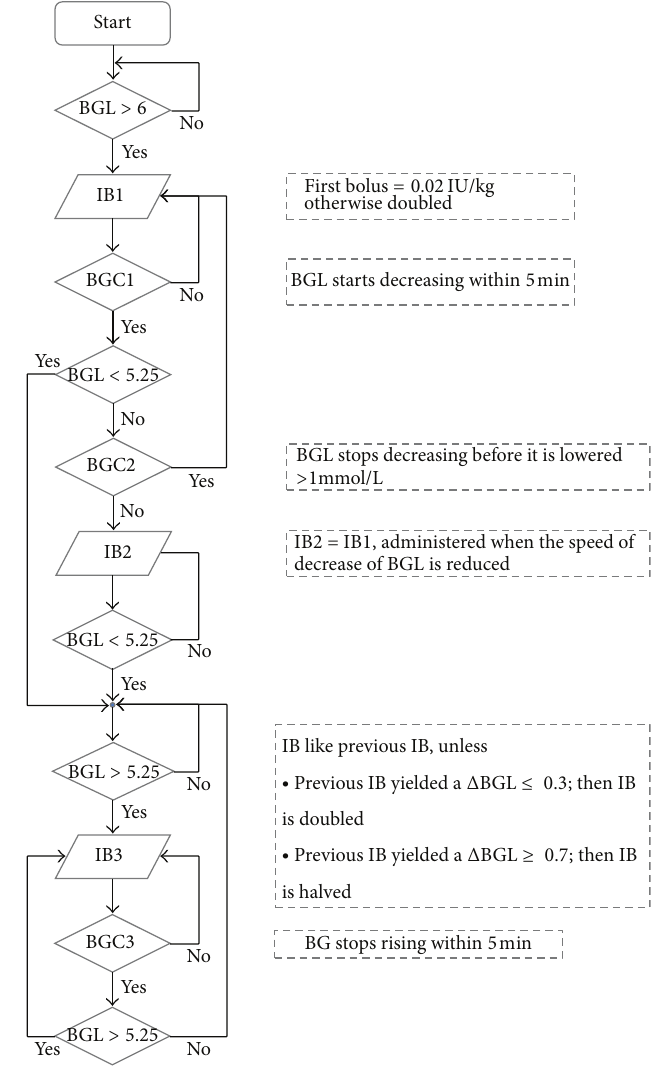
Figure 2: The current insulin algorithm; BGL: blood glucose level with the value in mmol/L; IB1–3: insulin bolus 1 to 3; BGC1–3 blood glucose control 1–3; Δ BGL the total amplitude in blood glucose level between two consecutive insulin